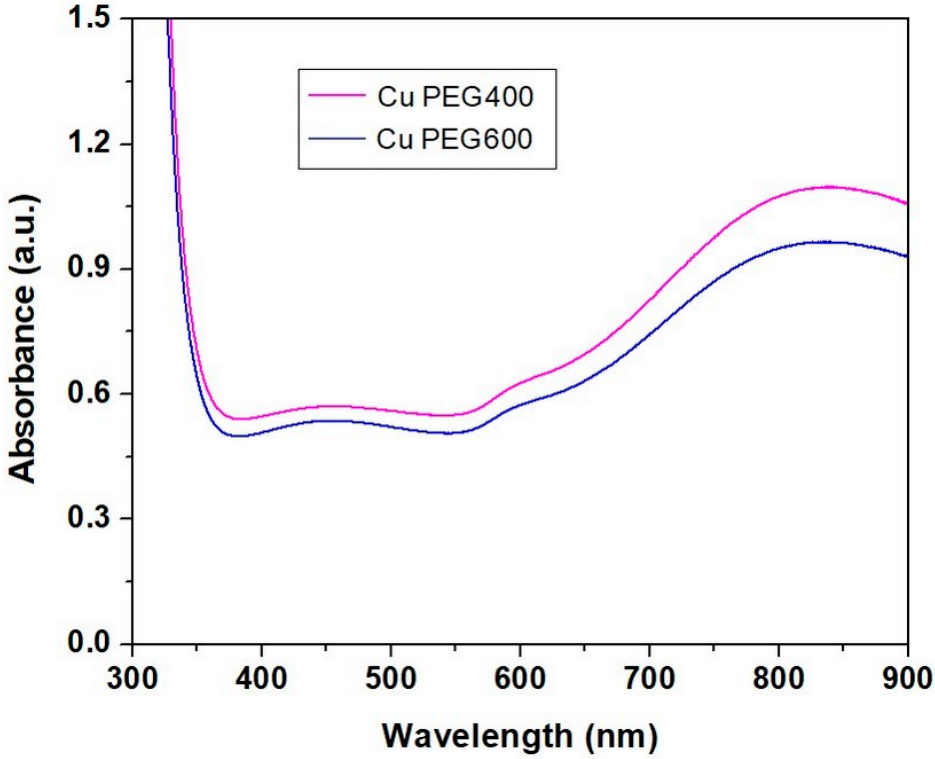
Figure 5. UV-VIS spectra of copper clusters obtained in PEG 400 and PEG 600, respectively.